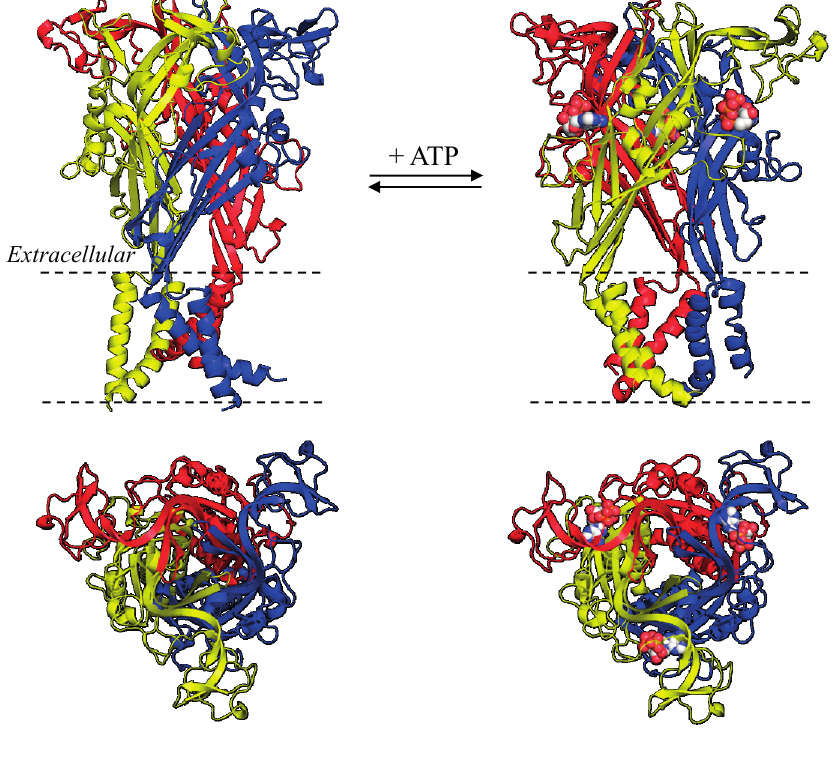
Figure 1. Structural homology models of the trimeric human P2X7 receptor. ( Left ) closed state; and ( right ) ATP-bound open state, viewed parallel to the plasma membrane ( top ) or the extracellular side ( bottom ). The three subunits are denoted in different colours, and the three bound ATP molecules are highlighted in